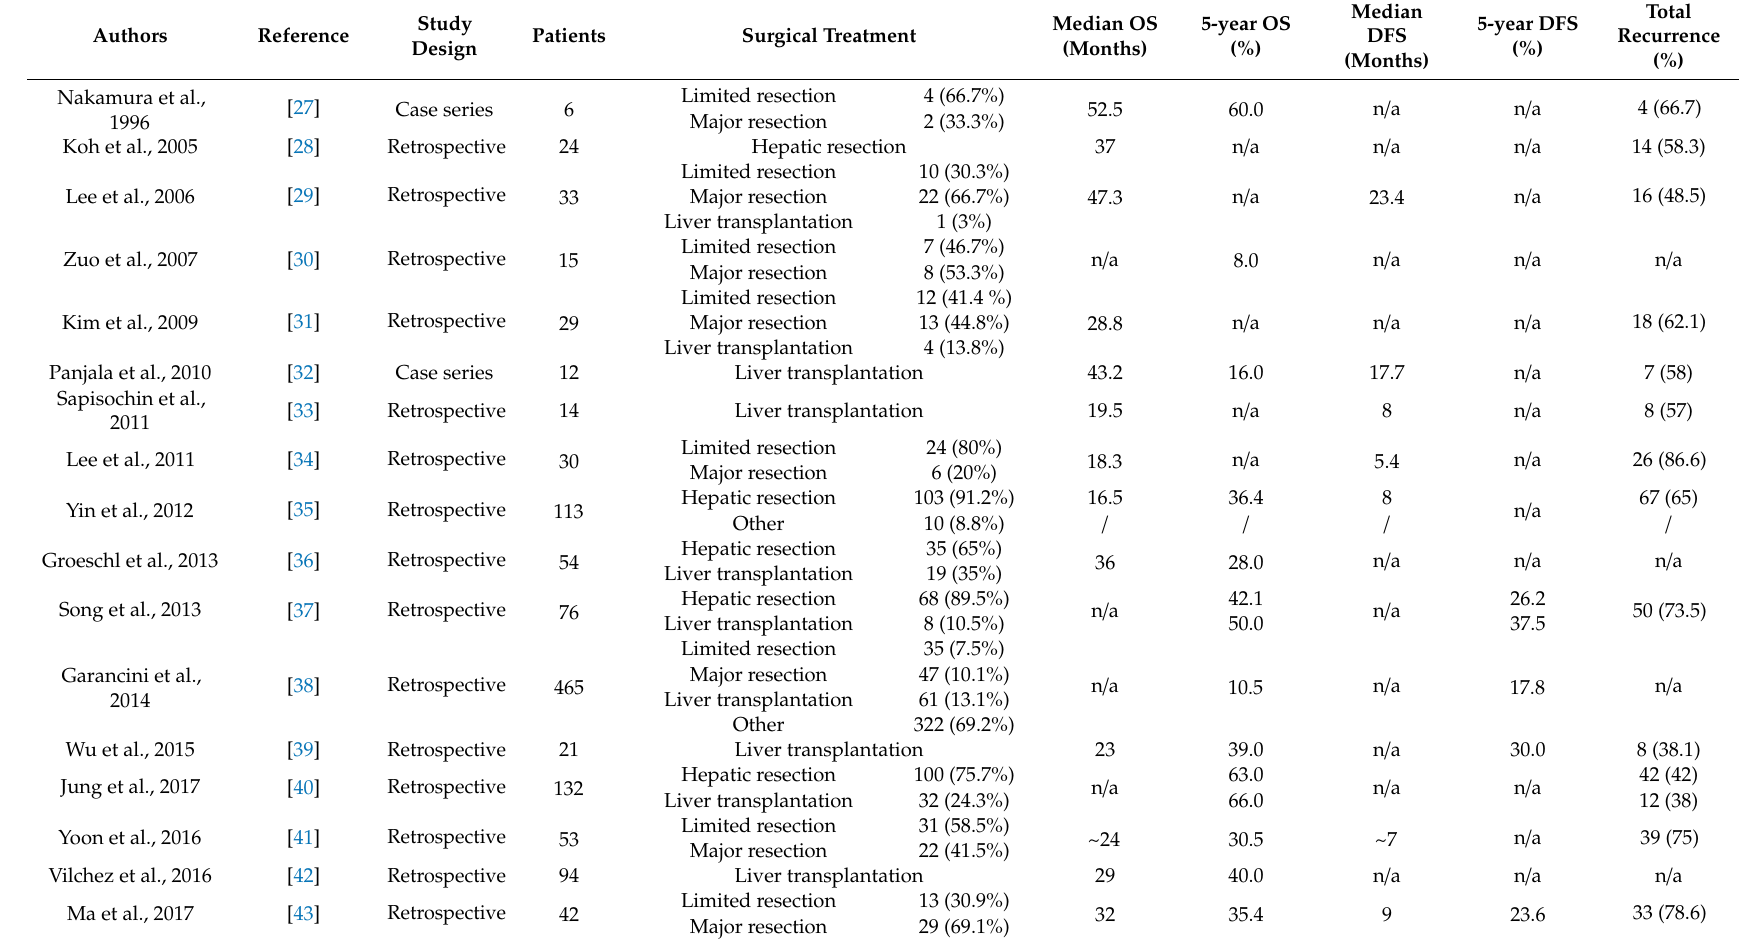
Table 1. Main studies of surgery in patients with combined hepatocellular and